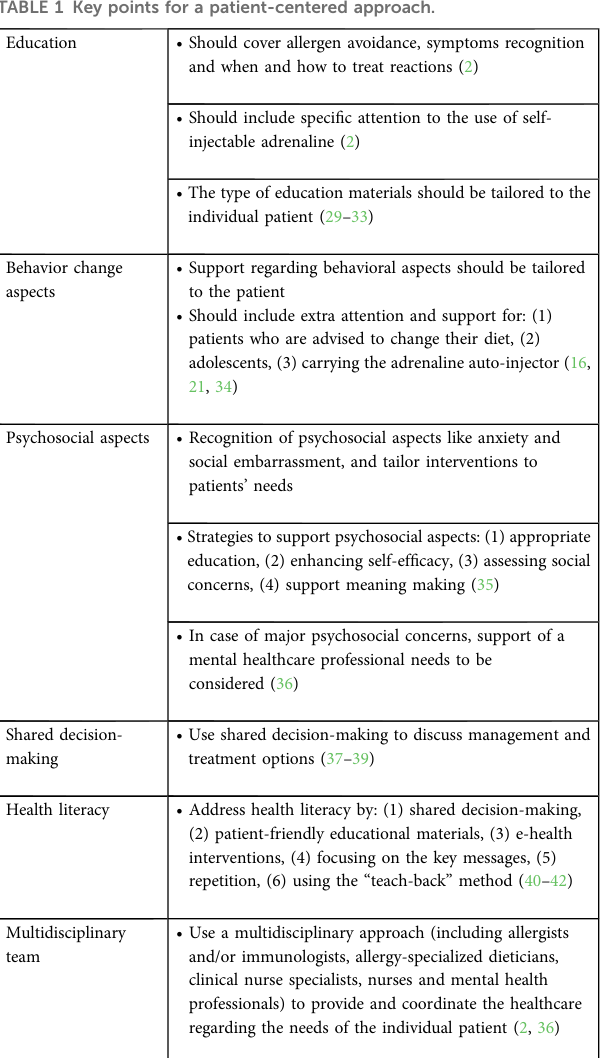
TABLE 1 Key points for a patient-centered